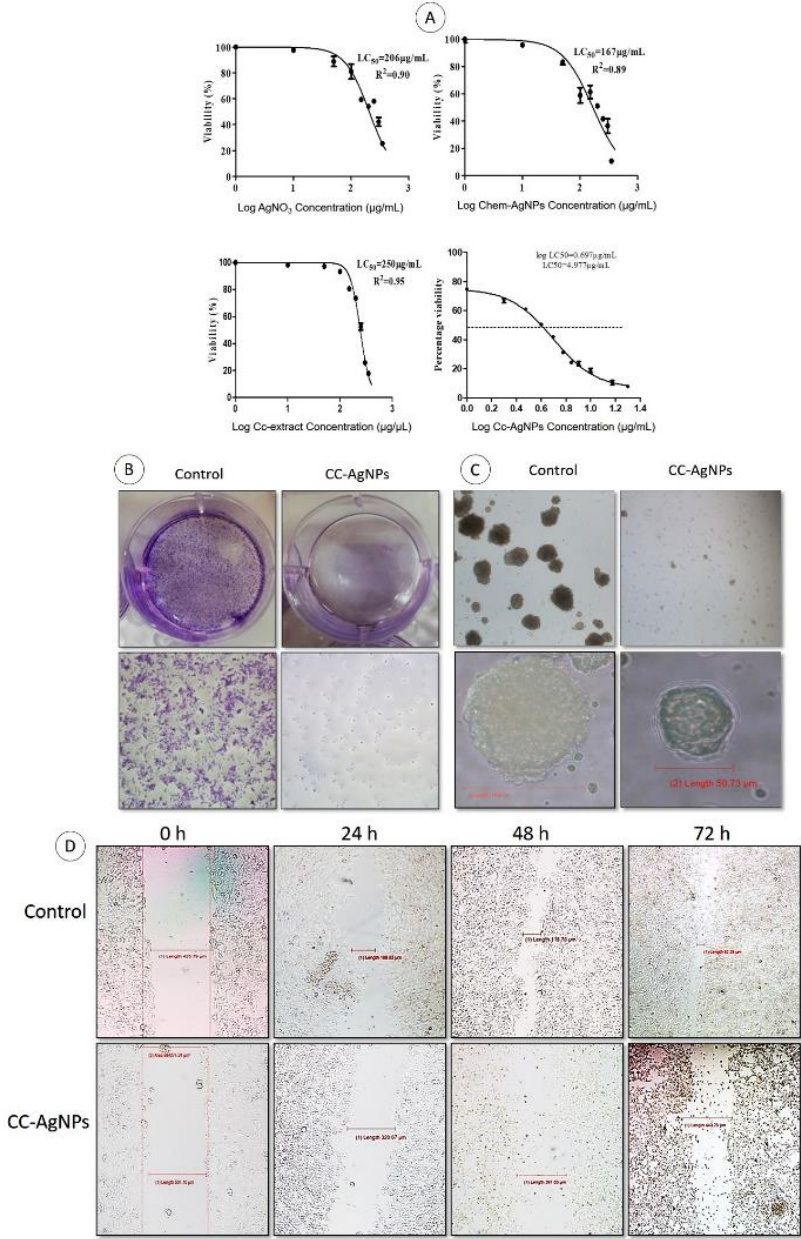
Figure 5. ( A ) MTT cell viability assay of AgNO 3 , Chem-AgNPs, Cc extract, and Cc-AgNPs indicates their dose-dependent cytotoxic potential. ( B ) Colony formation assay indicates the significant potential of Cc-AgNPs to decrease the clonogenicity of MCF7 cells. ( C ) Spheroid formation assay depicts the reduction in 3D growth potential in Cc-AgNP-treated cells. ( D ) Scratch assay shows the reduced migration and proliferation potential of Cc-AgNPs in time-dependent manner.